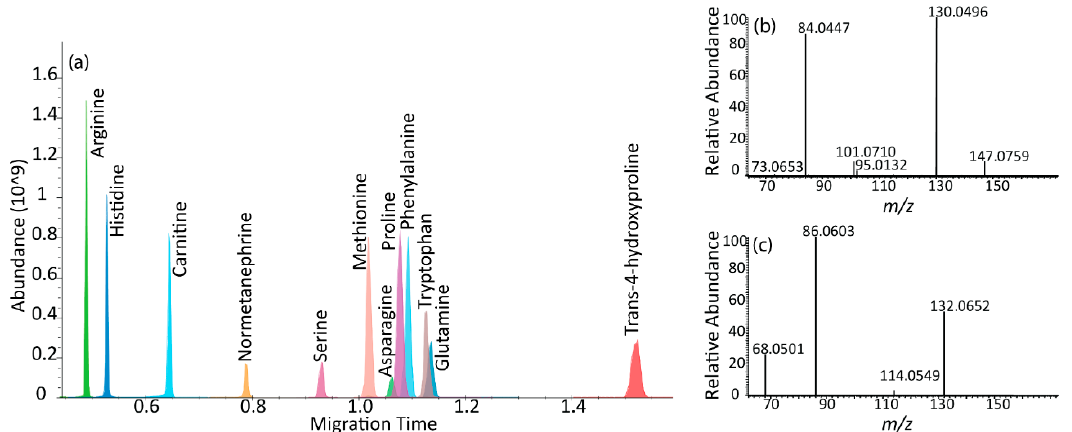
Figure 4. µCE-MS/MS separation. ( a ) Extracted ion electropherogram (XIE) of 12 metabolites in a scheduled and multiplexed PRM method. The x -axis represents the migration time in minutes and the y -axis shows the MS peak abundance. ( b ) PRM transitions for glutamine with precursor m/z 147.0759 at HCD 35 ( c ) PRM transitions for trans-4-hydroxyproline with precursor m/z 132.0652 at HCD 35. Most important, MS method parameters: AGC target value 1E5 and maximum ion injection time of 20ms. Spectral multiplexing (MSX) count of 6.